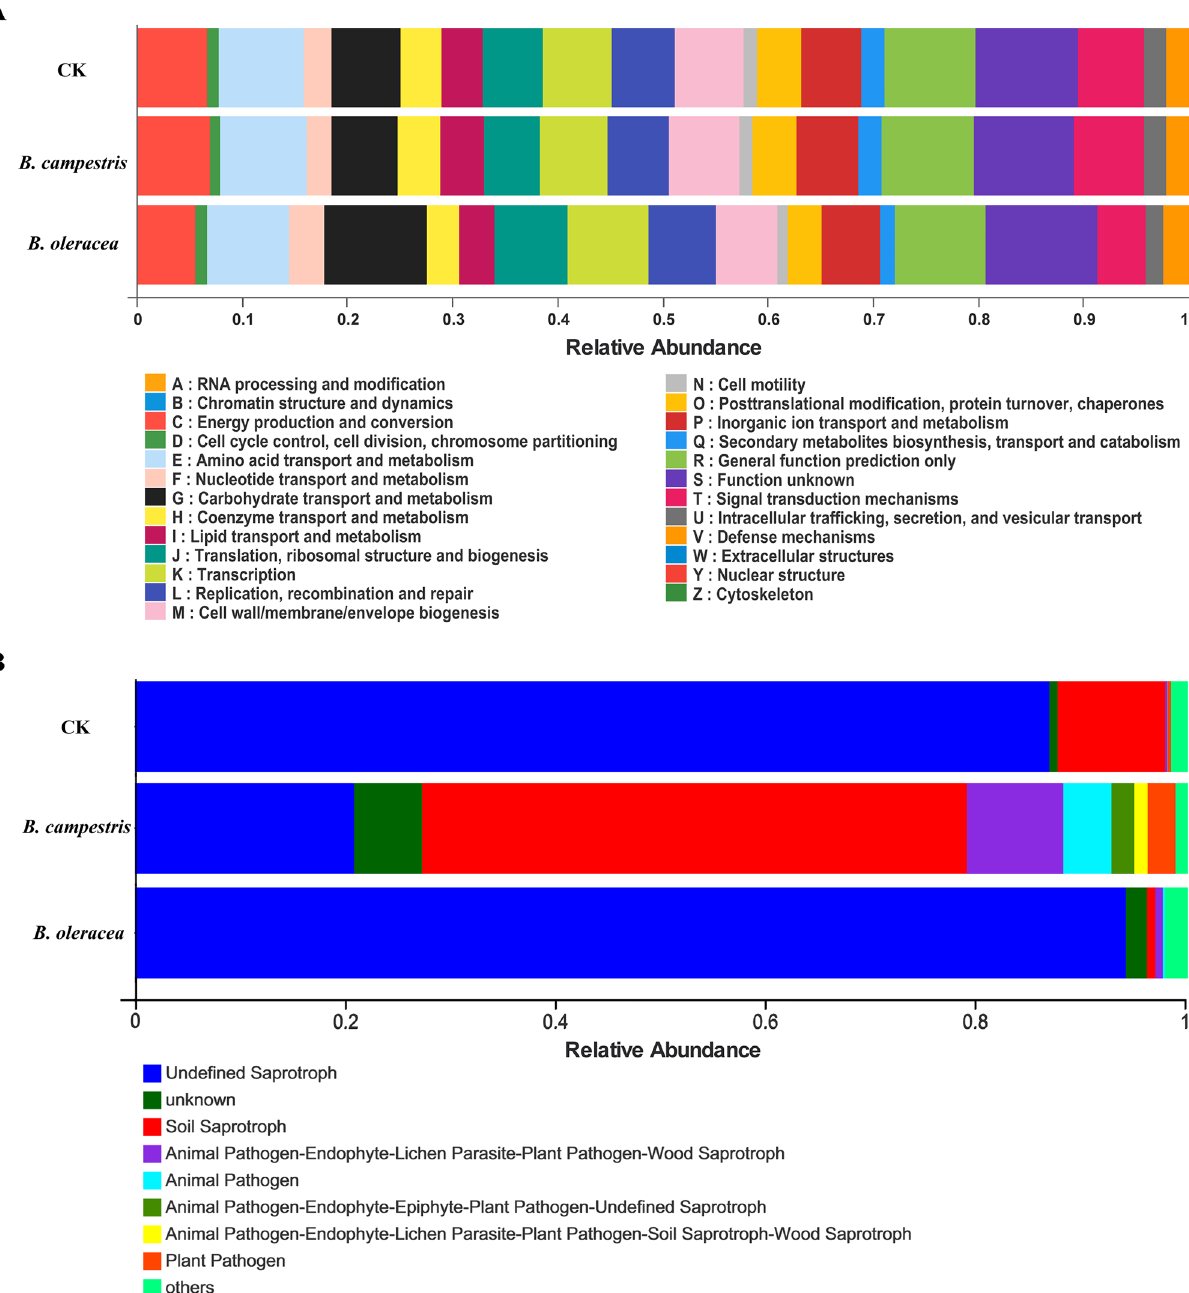
Figure 7. Functional classification of the gut microbial community in S. frugiperda larvae . ( A ) Bacterial function classification in S. frugiperda larval midgut with different diets by the PICRUSt tool. ( B ) Fungal function classification in S. frugiperda larval midgut with different diets by the FUNGuild tool. CK: the group fed on an artificial diet, B. campestris: the group fed on B. campestris; B. oleracea: the group fed on B. oleracea. The figure was created by PICRUSt (version 2.2.0) (https:// github. com/ picru st/ picru st2/) and Tax4Fun software (version 0.3.1) (http:// tax4f un. gobics. Midgut microbial function classification. The tool PICRUSt was used for midgut bacterial function classification, and 25 bacterial function categories were classified. Compared to the control group, no COG cat- egory showed a significant difference in the group fed on B. campestris , while 22 categories had significantly dif- ferent abundances in the group fed on B. oleracea (Fig. 7A). Among them, the categories of B (Chromatin struc- ture and dynamics), C (Energy production and conversion), D (Cell cycle control, cell division, chromosome partitioning), E (Amino acid transport and metabolism), F (Nucleotide transport and metabolism), H (Coen- zyme transport and metabolism), J (Translation, ribosomal structure and biogenesis), L (Replication, recombi-